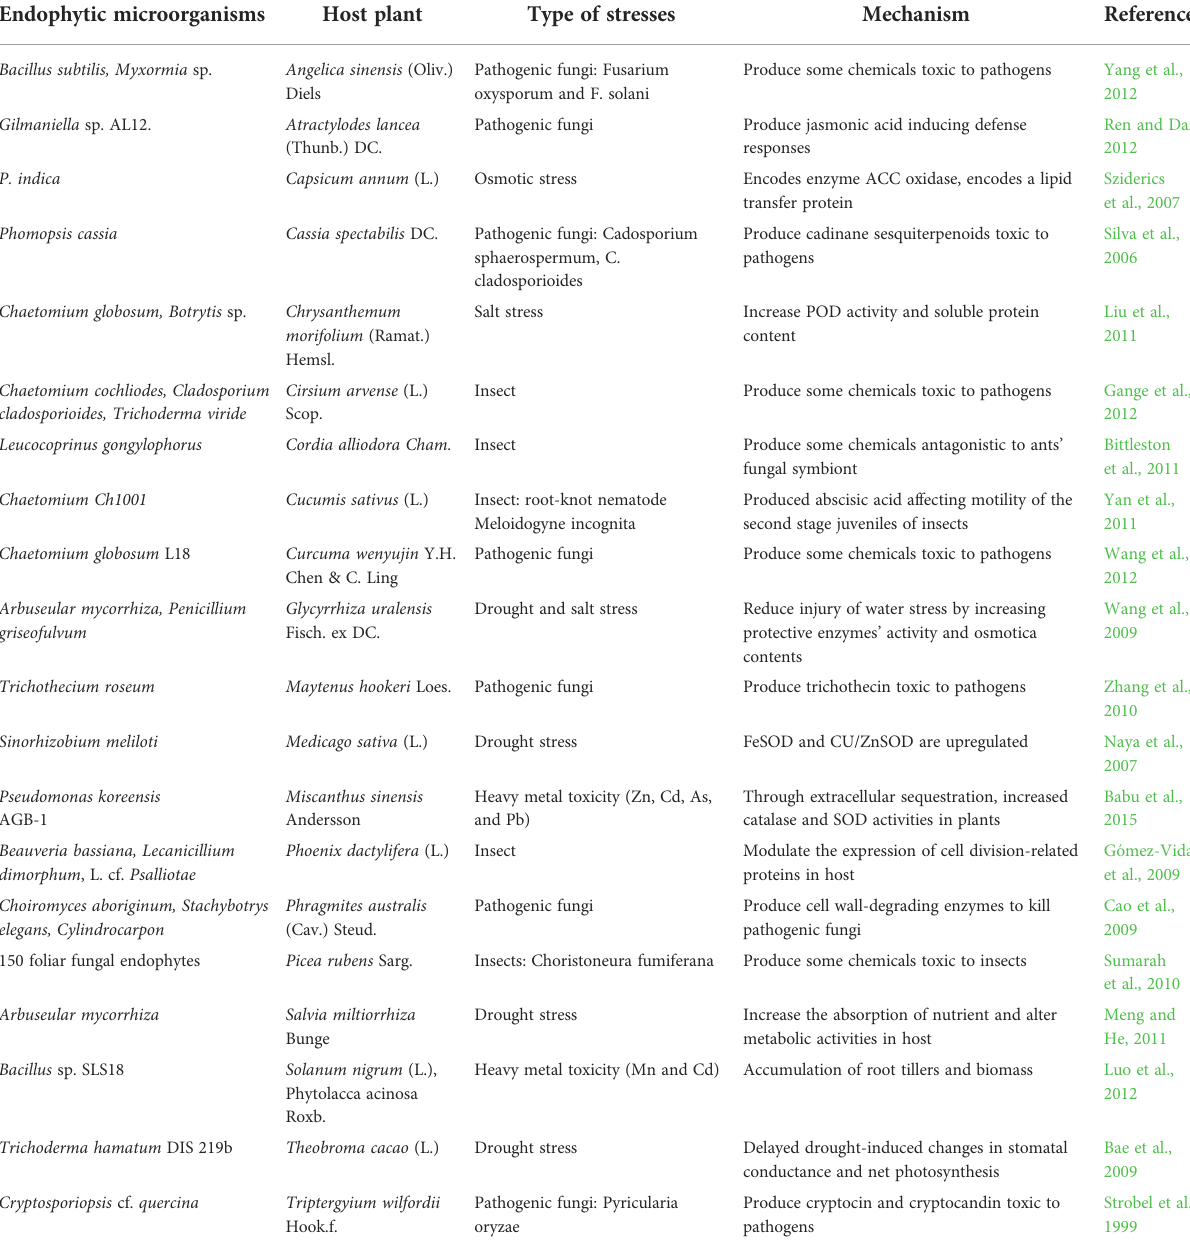
TABLE 2 Host medicinal plants with enhanced defense responses conferred by endophytic